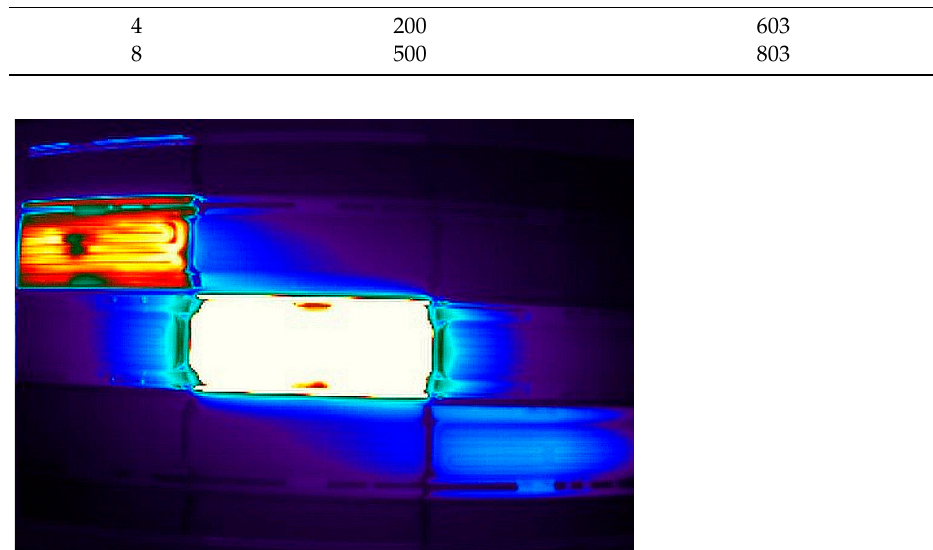
Figure 11. Heating elements number 4 and 8 with surface temperature of 603 K and 803 K, respec- tively.